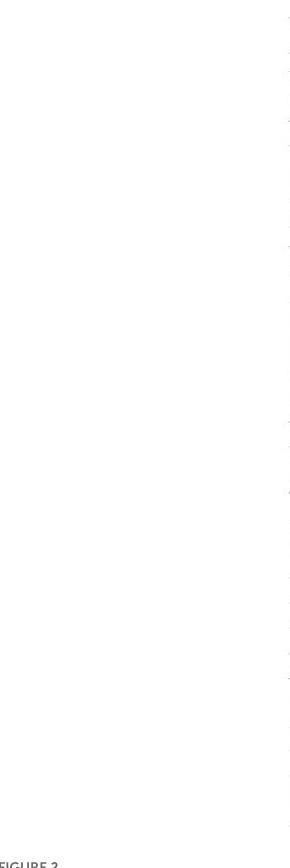
FIGURE2 The cannabis use and psychosis